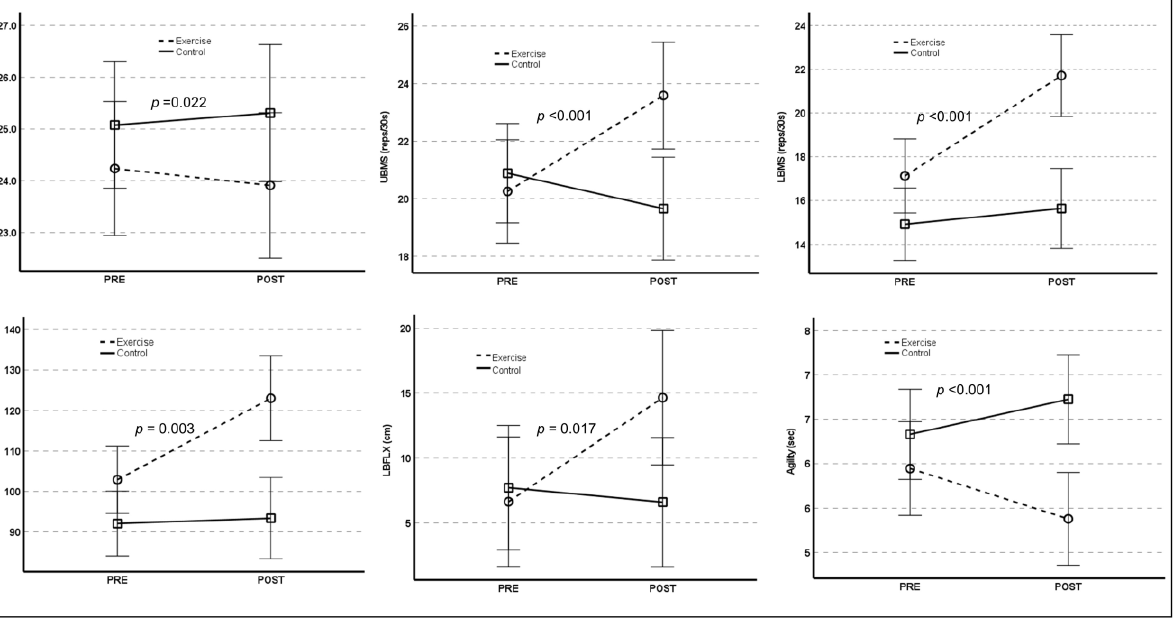
Figure 3. Illustration of time-by-group interactions for body mass index and physical functional capacity. BMI: body mass index; UBMS: upper body muscle strength; LBMS: lower body muscle strength; LBFLX: lower body flexibility.